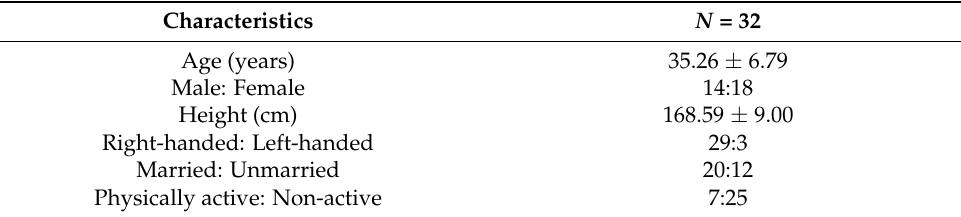
Table 2. General characteristics of